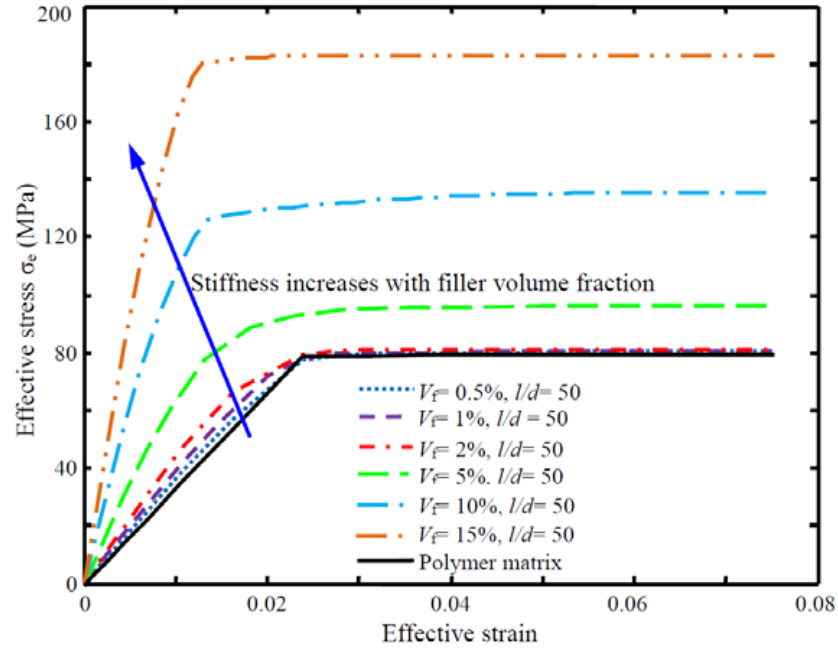
Figure 14. Effective stress-strain diagram σ e - ε e of the PNCs with the clay-particle aspect ratio ρ = 50 (plane-strain, case II).